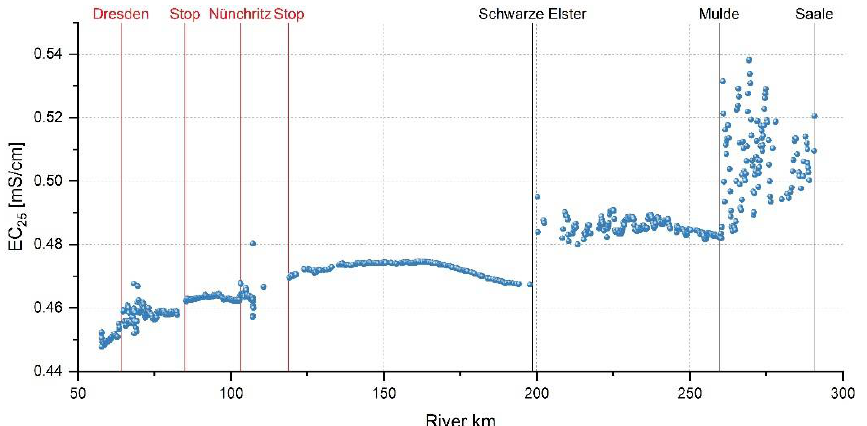
Figure 12. EC 25 plotted against river km of the Elbe. Only the investigated stretch of the Elbe River prior to the mouth of the Saale is depicted. Major tributaries are marked with black lines. An increase in EC 25 values can be observed after the mouth of the Schwarze Elster and the Mulde. Red lines mark noticeable changes in EC 25 unrelated to tributaries.